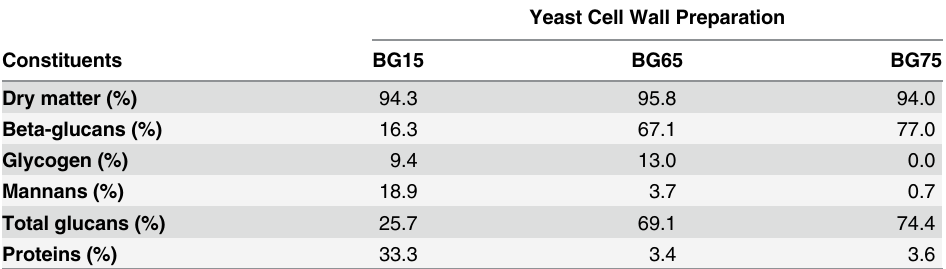
Table 1. Main composition of the Saccharomyces cerevisiae cell wall